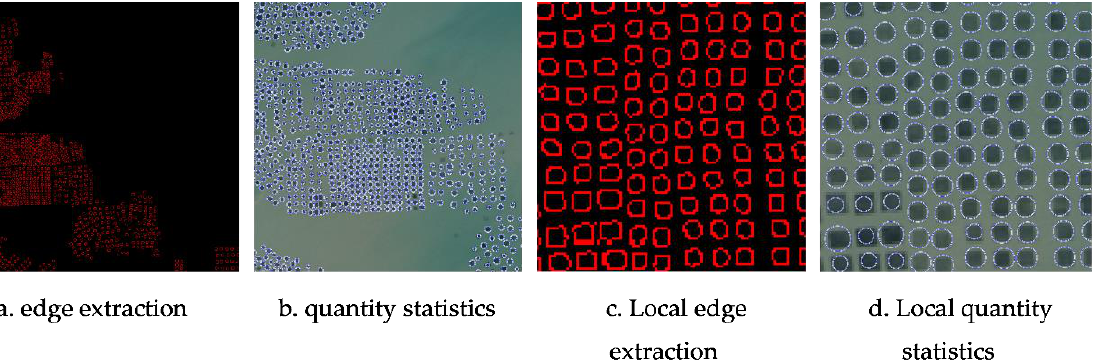
Figure 11. Local renderings of aquaculture raft extraction statistics: ( a , b ) the results of the identifi- cation and extraction of aquaculture rafts on the sea surface, respectively; ( c , d ) partial displays of extracted statistical results.